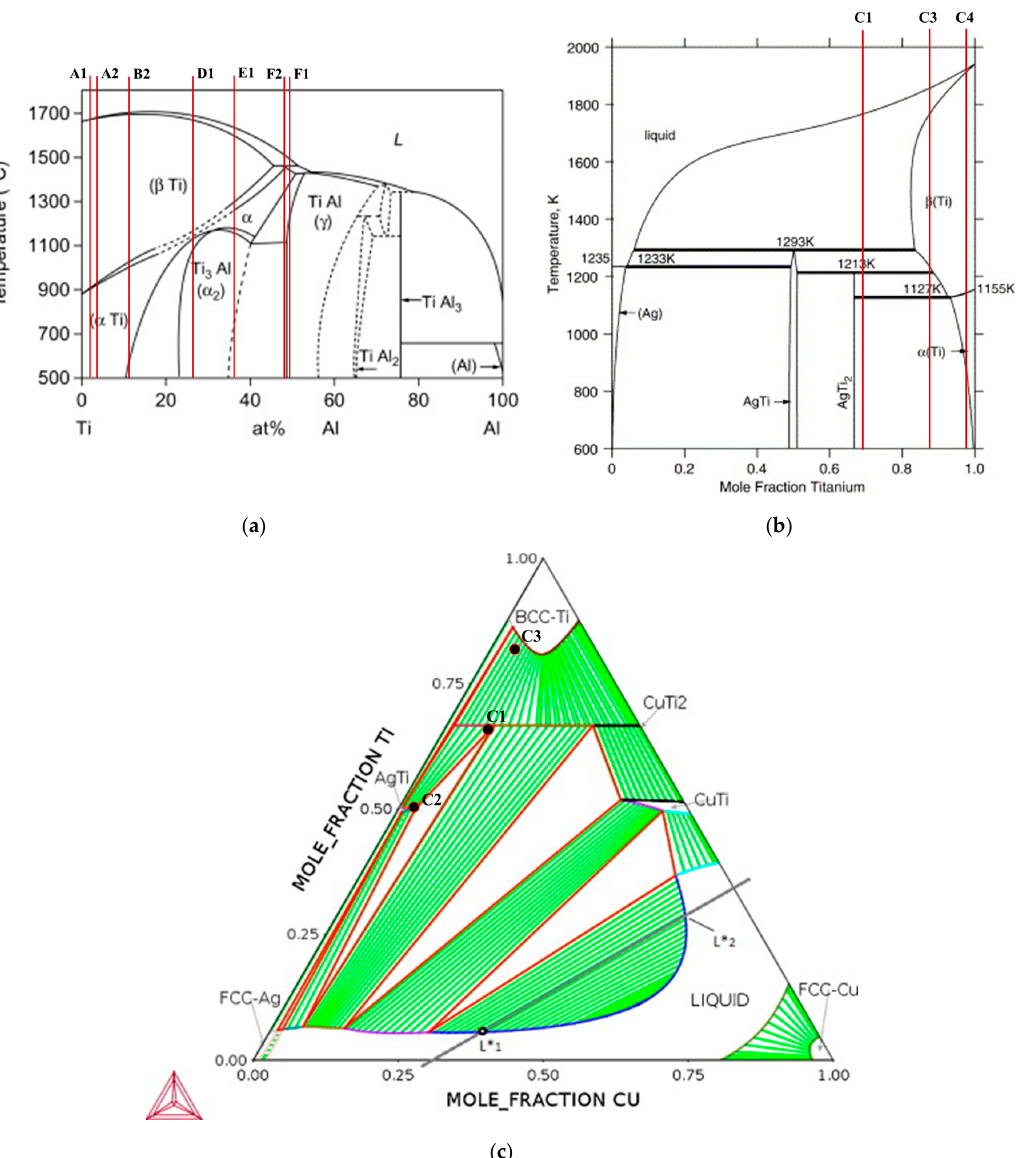
Figure 4. ( a ) Ti-Al [38], ( b ) Ti-Ag [39] and ( c ) Ti-Ag-Cu [40] phase diagrams with the EDS chemical composition of the zones marked in the SEM image of Al 2 O 3 / γ -TiAl alloy interface. Adapted with permission from [38–40]. Copyright 2005, 2015, 2018 Elsevier.